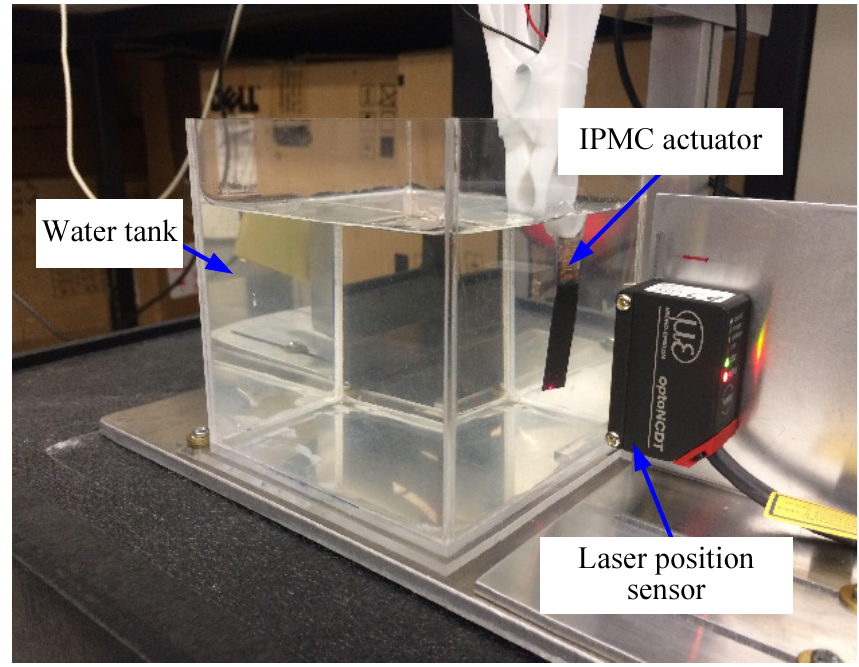
Figure 1. Experimental setup of an IPMC soft actuator for position tracking control